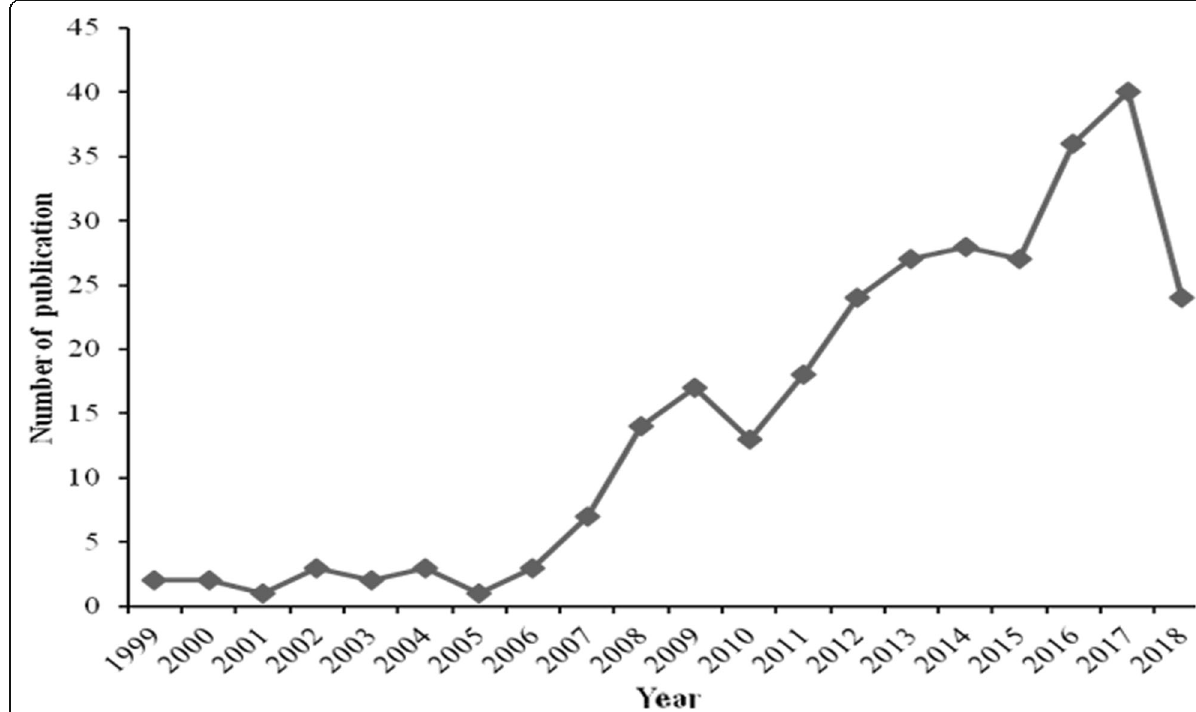
Fig. 1 The annual number of publication on acupuncture in insomnia